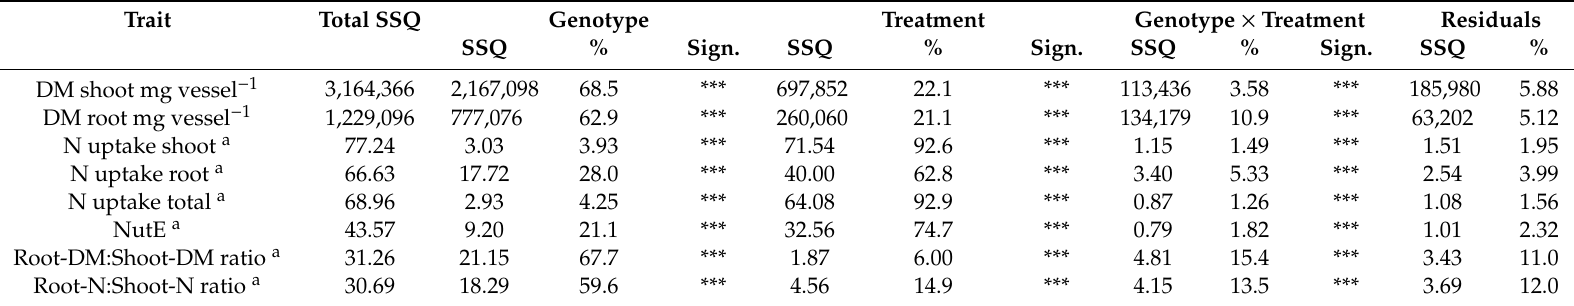
Table 3. Evaluated traits and variance explained (%) by the factors genotype, treatment and interaction. Given are the sum of squares (SSQ) resulting from two-factor analysis of variance and F-test.